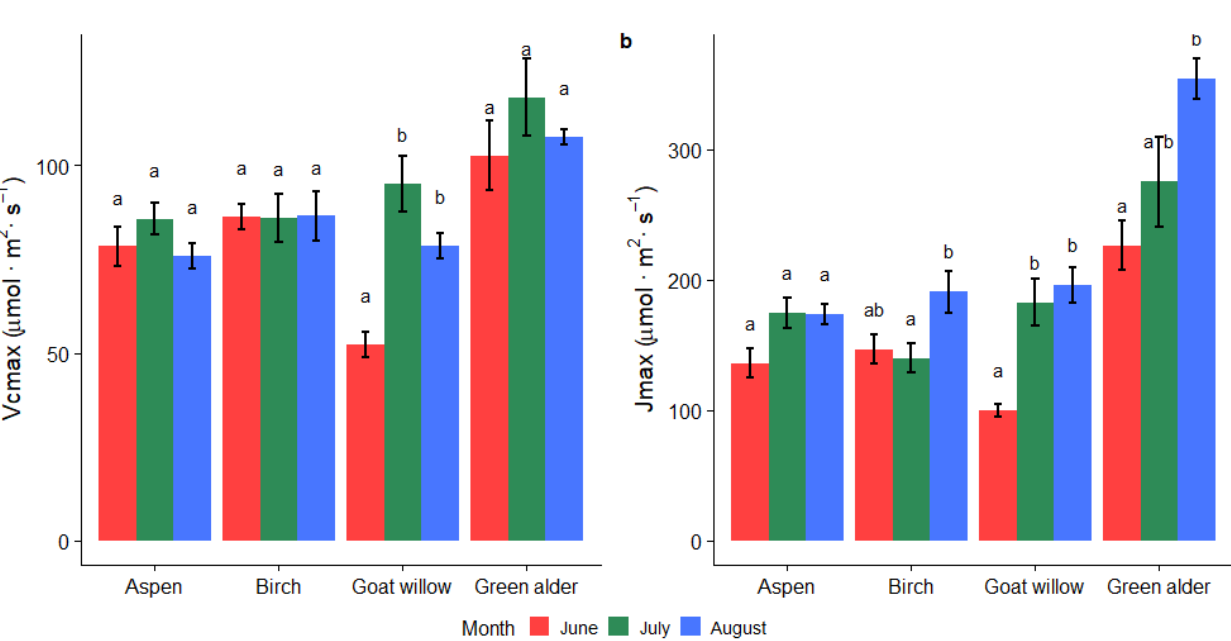
Figure 4. Mean values of FvCB model parameters for deciduous pioneer species on tailings dumps in the Călimani Mountains: ( a ) V cmax —maximum rate of Rubisco activity; ( b ) J max —maximum rate of electron transport for RuPB-regeneration (whiskers represent standard errors, and letters represent significant differences).